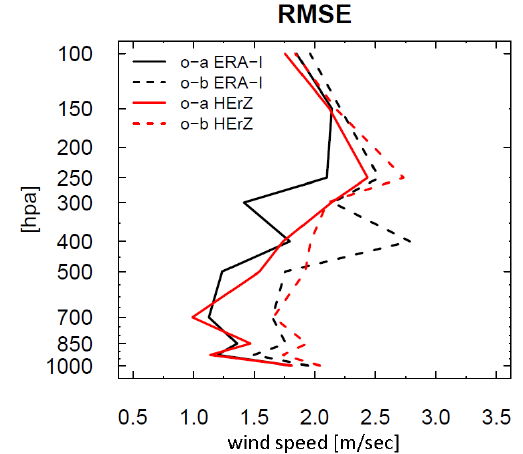
Figure 11. Root mean square errors of analysis departures (o-a, solid line) and background departures (o-b, dashed line) for Lin- denberg radiosonde observations of wind speed at standard pres- sure levels, in January 2011: feedback statistics for the ERA-Interim (black) and COSMO-REA6